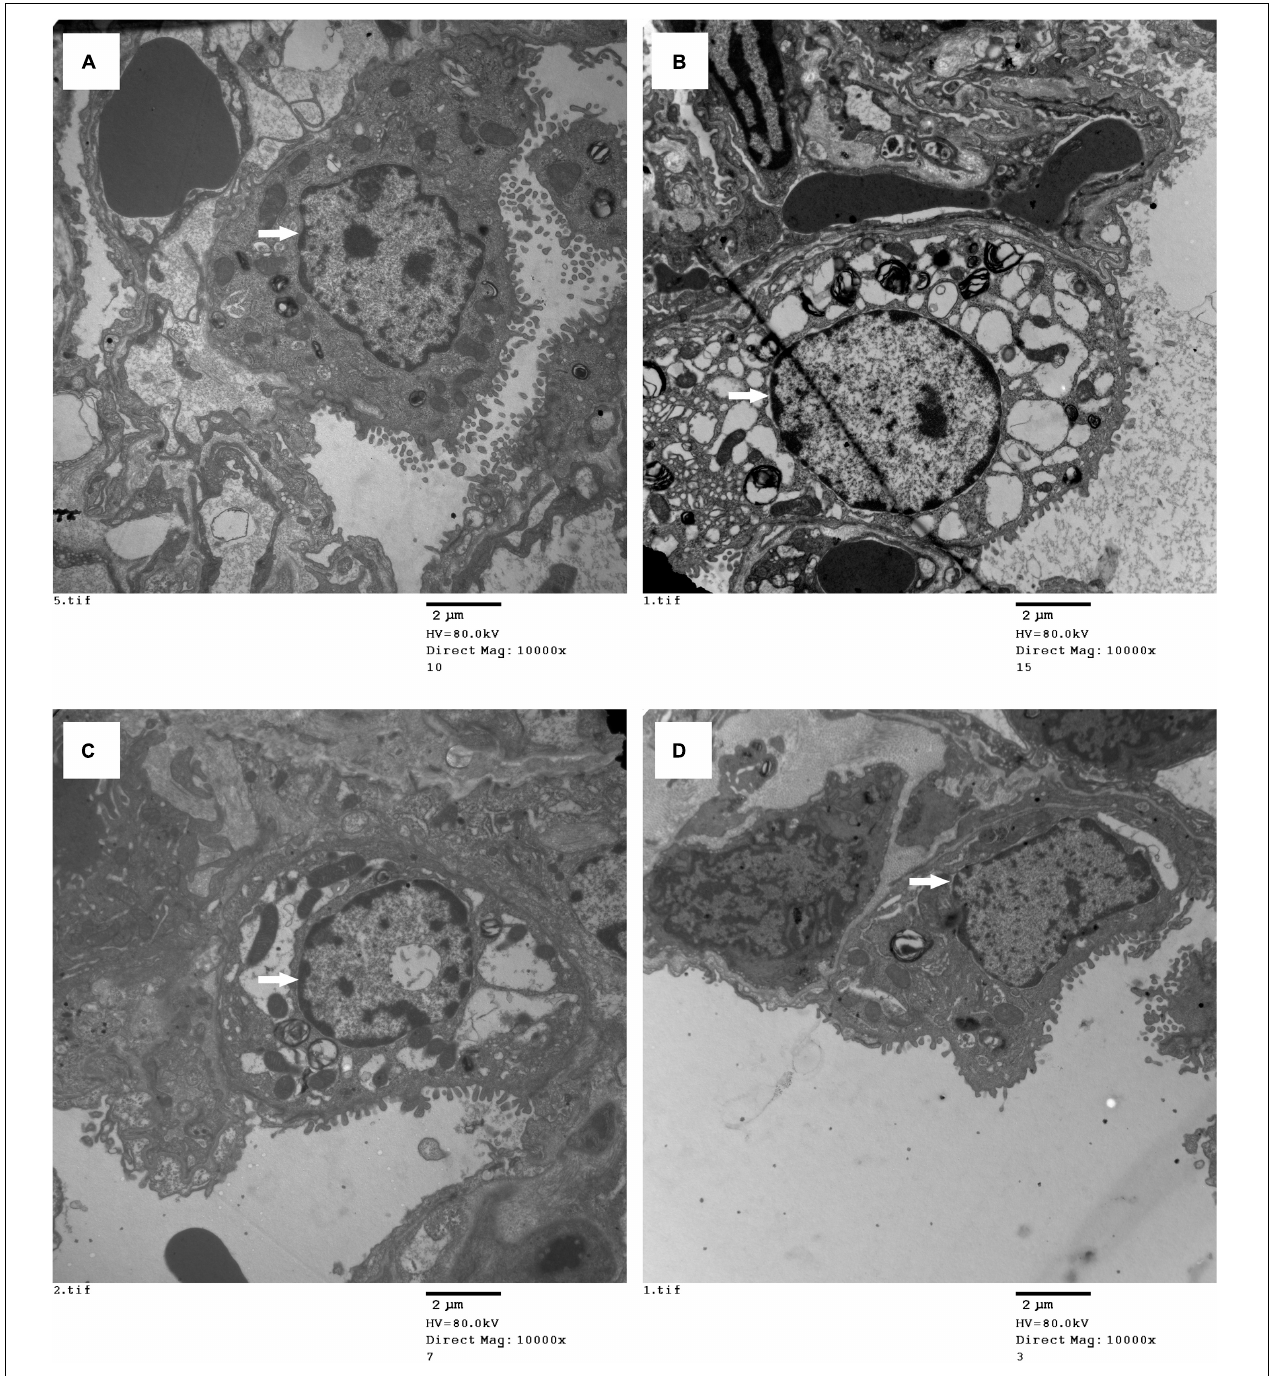
FIGURE 7 | Type II alveolar epithelial cell morphology was imaged with electron microscopy (original magnification, 10,000). (A) sham group; (B) control group; (C) O 2 group; (D) H 2 group. The type II alveolar epithelial cell morphology was normal in the sham group, the swollen cell and nuclear pyknosis were observed in the control group, the changes were improved in the O 2 group, the cell had fewer changes in the H 2 group. ∗ P < 0.05 vs. sham group; # P < 0.05 vs. control group; (cid:77) P < 0.05 vs. O 2